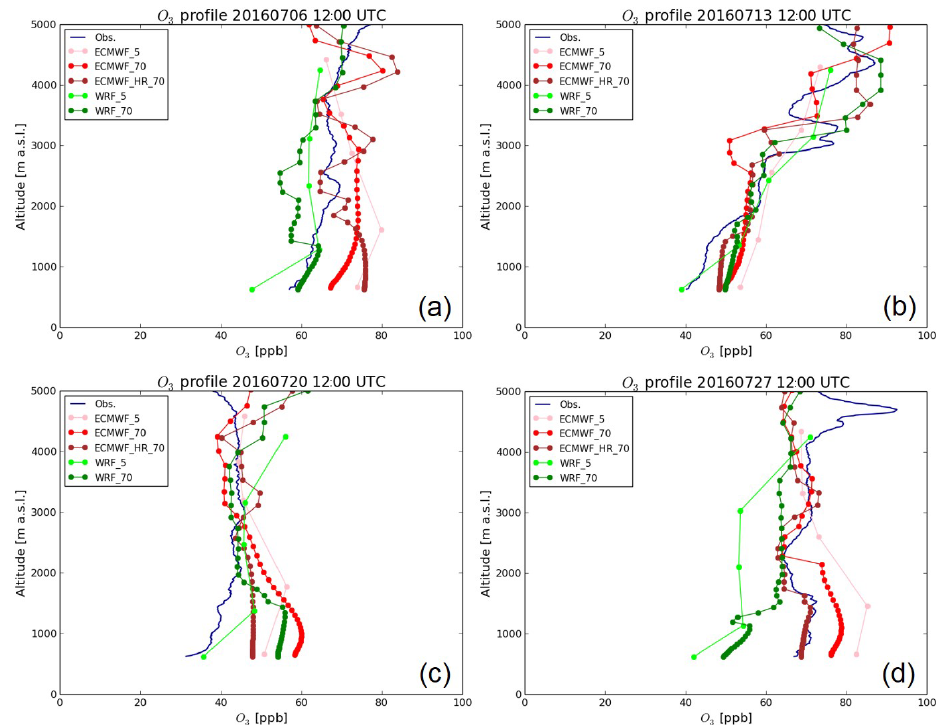
Figure 4. Real and simulated vertical profiles of O 3 for the 6, 13, 20 and 27 July